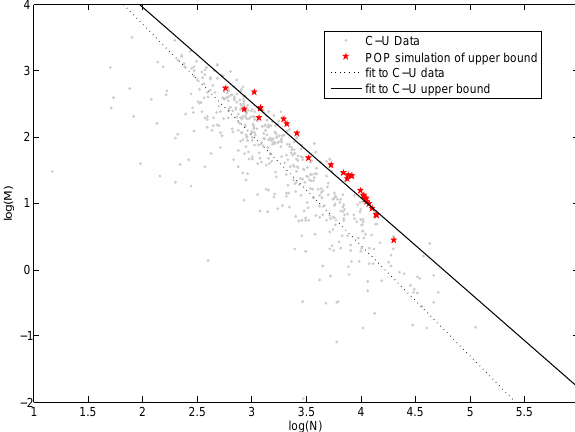
Figure 3. POP calibration. Biomass–density plot, showing all the points in the C–U data; a linear fit to all the C–U data; a linear fit to 30 data points lying along the upper bound; POP simulations of patches with the same age and StemNPP as the 30 data points lying along the upper